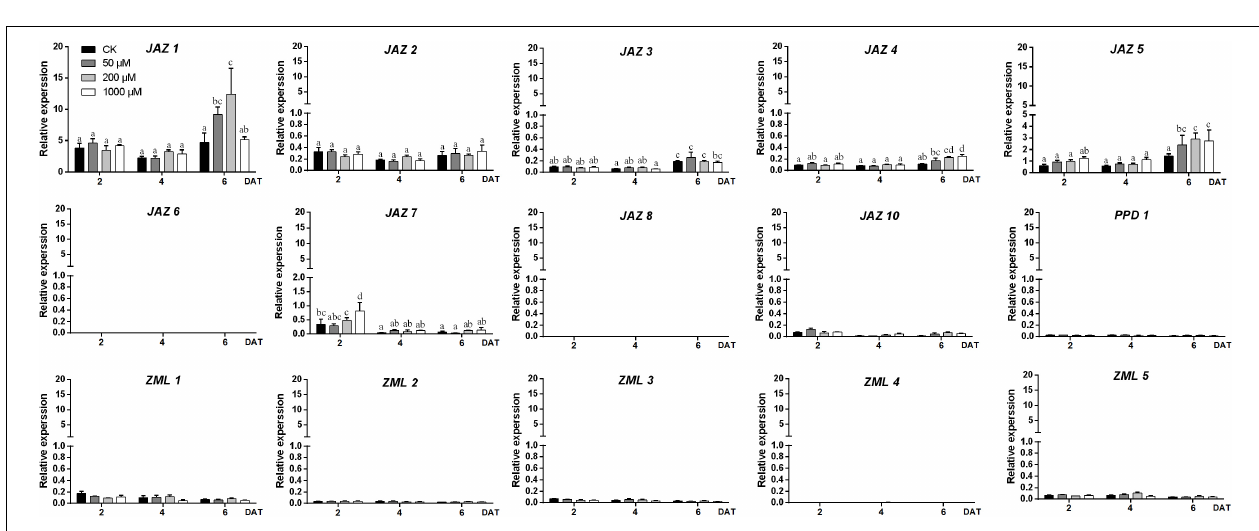
FIGURE 6 | Expression profiles of the peach JAZ , PPD or ZML genes in the epicarp of cv. “Zhong You 18” under exogenous MeJA treatment. The x -axis represents days after treatment (DAT). The y -axis represents the relative expression of TIFY members to the internal reference gene PpTEF2 . The error bars represent ± SE of three biological replicates. Significant difference at the 0.05 level is indicted by different lowercase letters based on a one-way ANOVA/Duncan’s test.